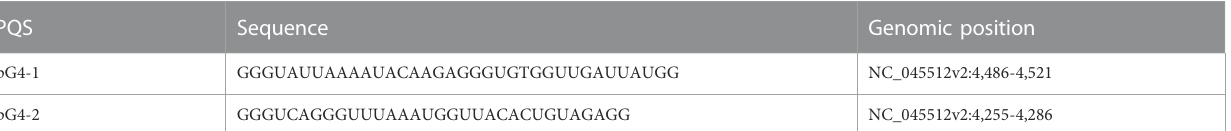
TABLE 1 New pG4s identi fi ed in the SARS-CoV-2 genome that have bulges. Their sequences, genomic positions are mentioned.